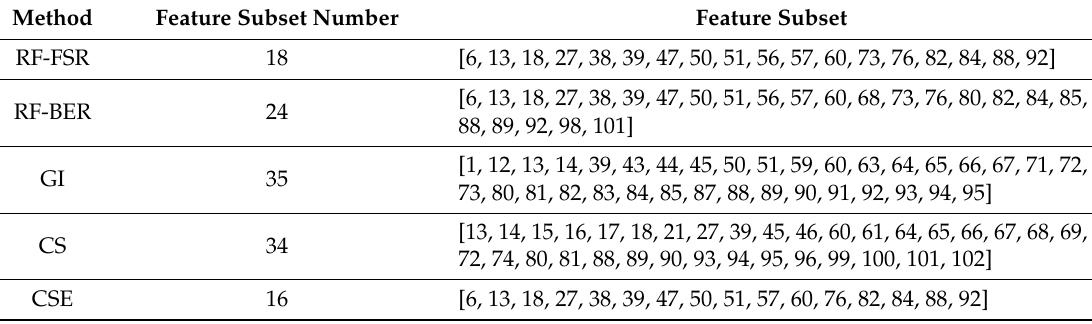
Table 6. Comparison of TCP flow dataset feature selection algorithms.